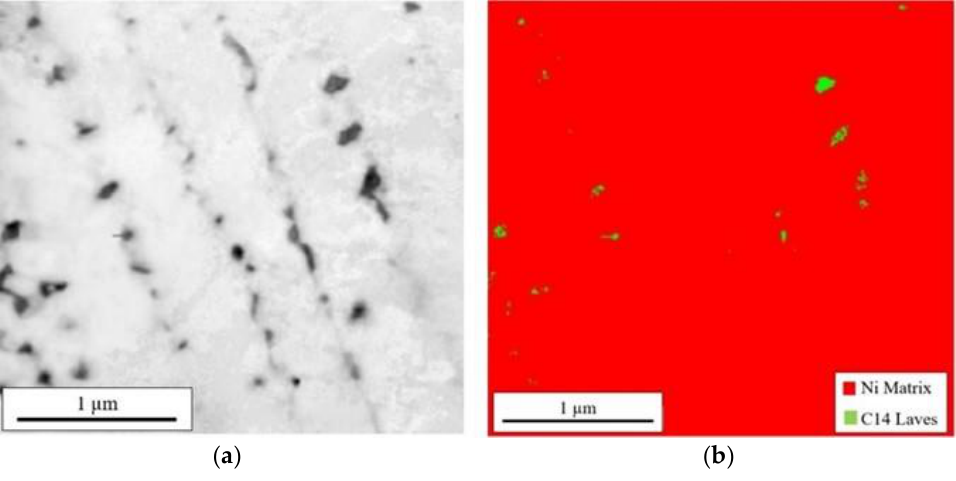
Figure 9. IQ map of columnar structures ( a ) and the corresponding TKD phase distribution map showing the γ (or FCC) matrix in red and the Laves phase in green ( b ).